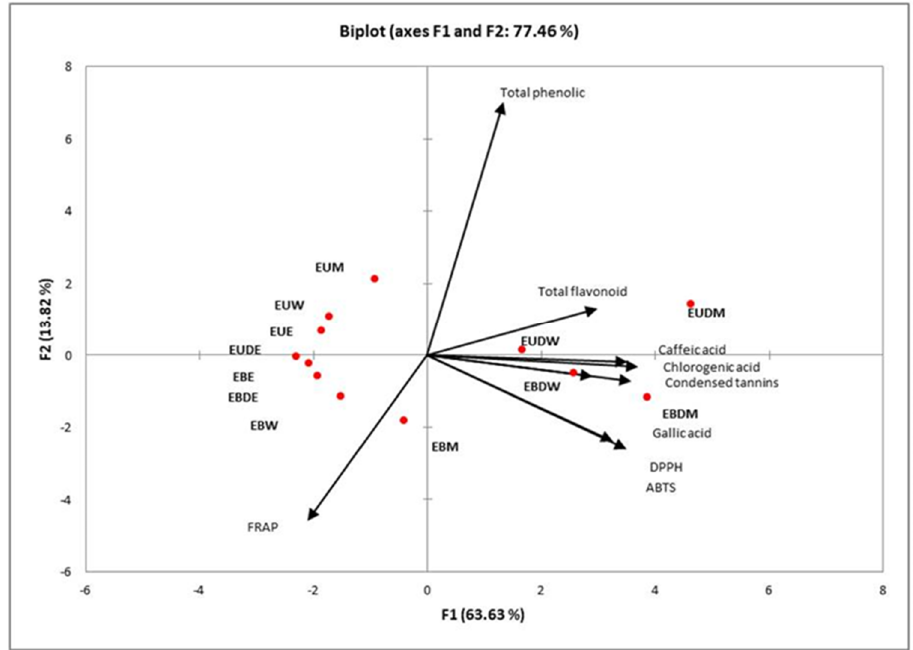
Figure 3. Principal component analysis (PCA).